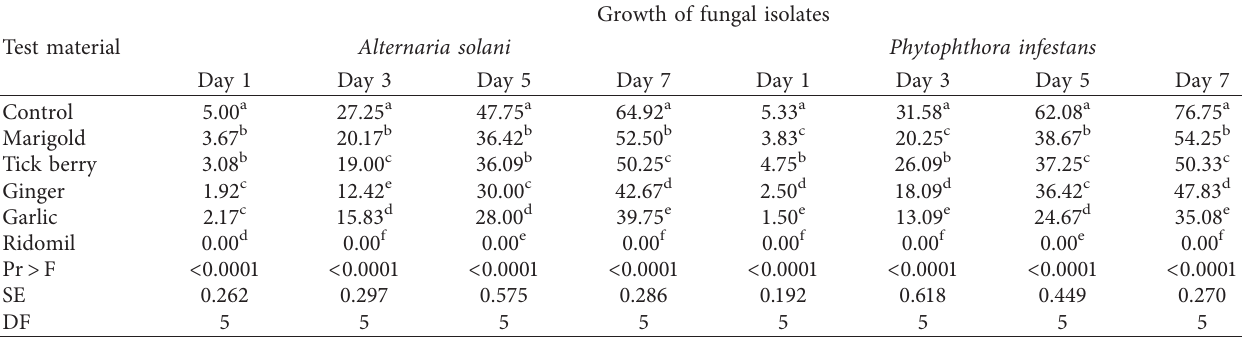
Table 2: Antimicrobial activity of methanol-extracted plant extracts on the growth of the fungal pathogens. Test material